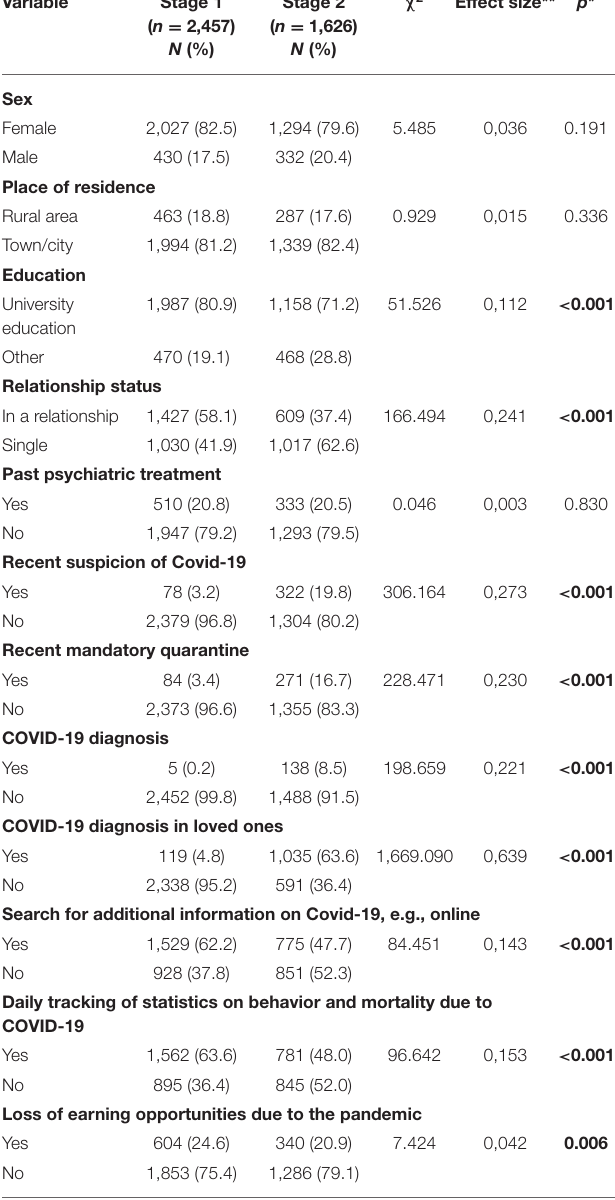
TABLE 2 | Analysis of the GAD-7 and the COVID-19 subjective feeling of anxiety scale concerning oneself, neighbors and their quarantine and adherence to government